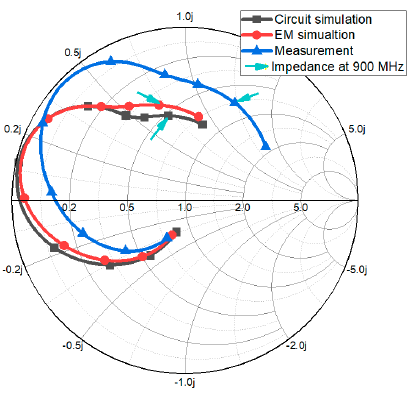
Figure 4. Simulated and measured impedances of the proposed impedance tuner from 100 MHz to 1000 MHz.